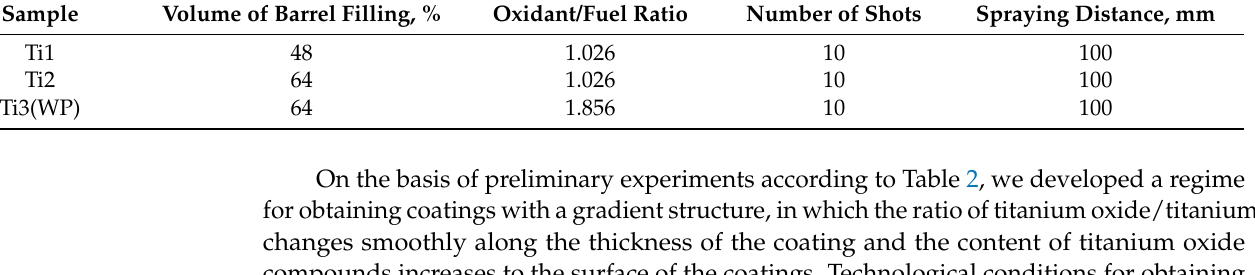
Figure 1. The CCDS2000 setup schematic diagram: 1—controlling computer; 2—distribution com- pany; 3—mixing chamber; 4—spark plug; 5—barrel damper; 6—fuel line; 7—oxygen line; 8—gas valves; 9—gas distribution unit; 10—barrel indicated part; 11—powder feeder; 12—workpiece; 13— manipulator; and 14—the barrel muzzle, F 1 —acetylene, F 2 —propane–butane, O 2 —oxygen and N 2 — nitrogen.